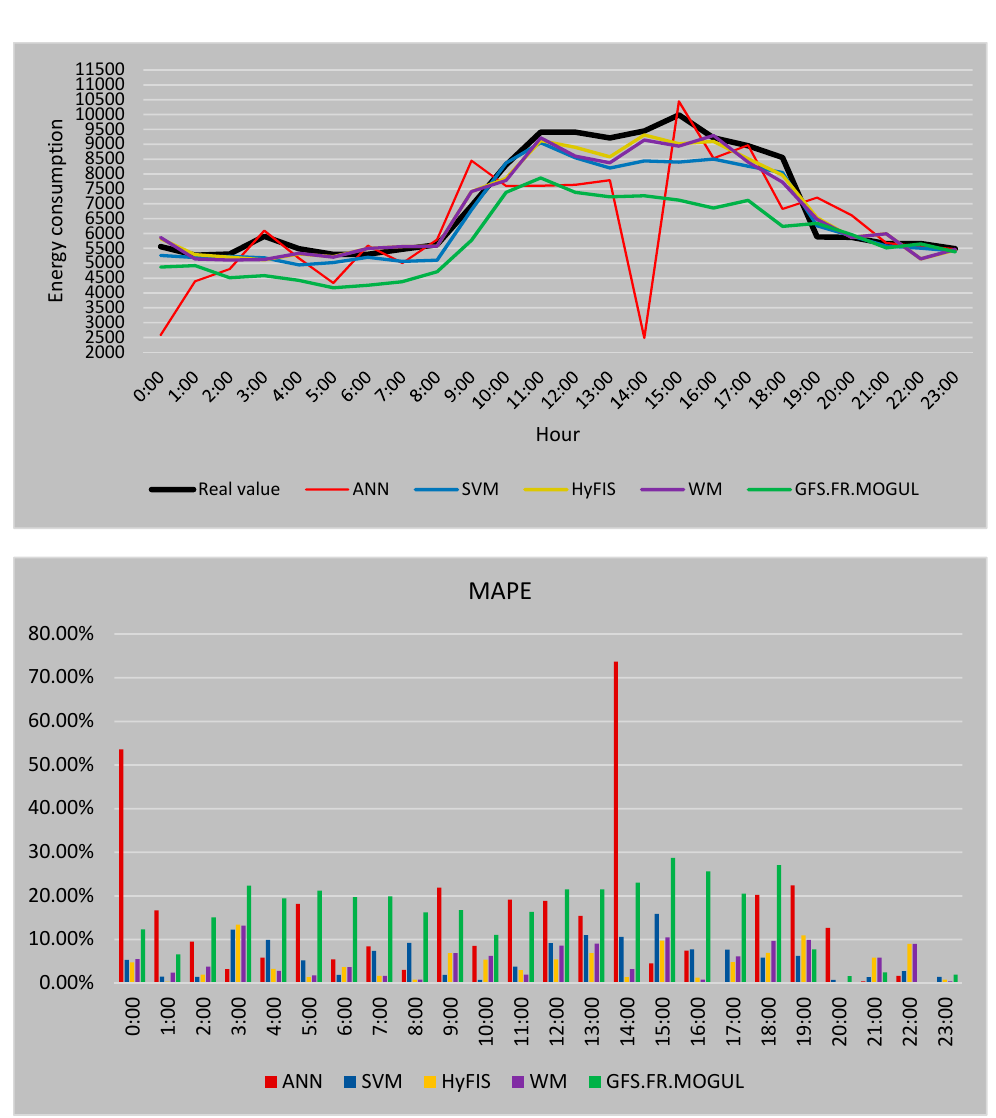
Figure 15. Forecasted values and error of the methods using the 4th data preparation strategy.